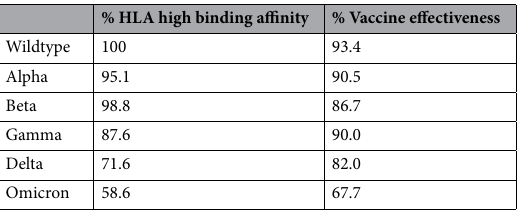
Table 5. HLA high affinity binding and vaccine effectiveness for 6 SARS-CoV-2 variants.